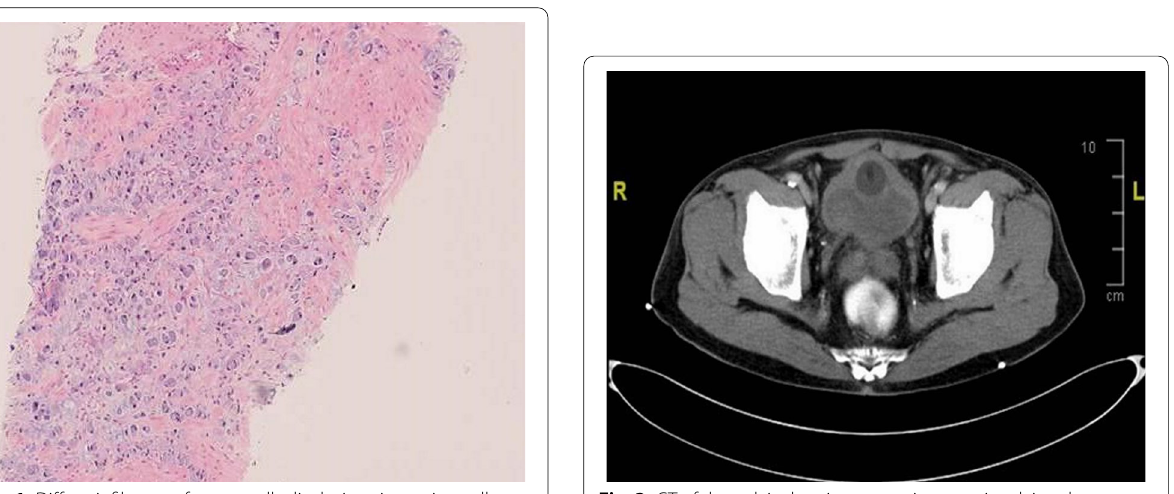
Fig. 3 CT of the pelvis showing prostatic tumor involving the seminal vesicles and protruding into the bladder